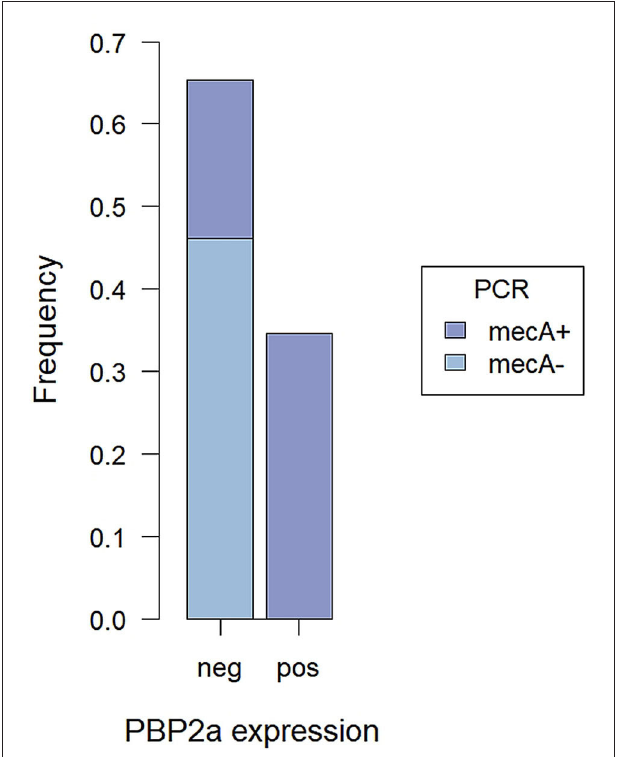
FIGURE 3 | Proportions of mecA + and mecA − SP tested by PCR among cases with detected and not PBP2a expression by immunofluorescence assay.